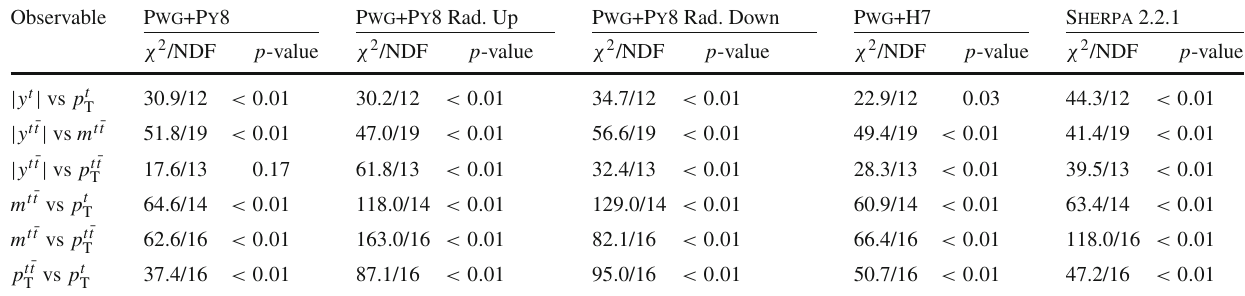
Table21 Comparisonofthemeasuredparton-levelnormaliseddouble- differential cross-sections in the resolved topology with the predictions from several MC generators. For each prediction a χ 2 and a p -value are